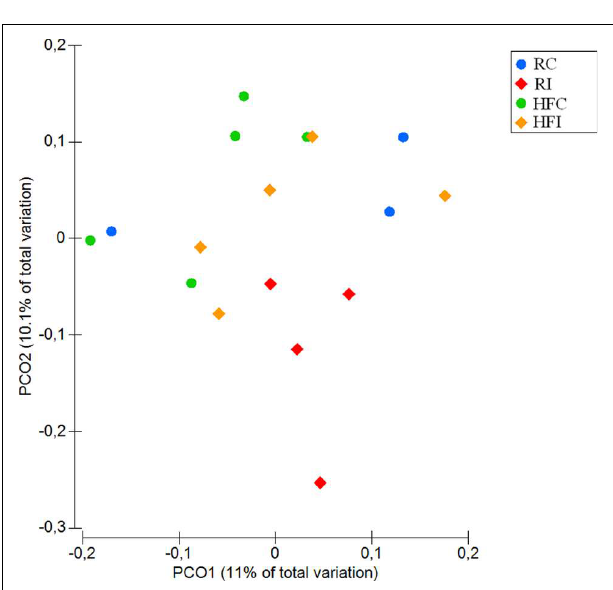
FIGURE 6 | Principal coordinates analysis (PCoA) of unweighted UniFrac distances of samples from sacculus rotundus. Significant p -value = 0.032 for Infected vs. non-infected comparison was obtained from